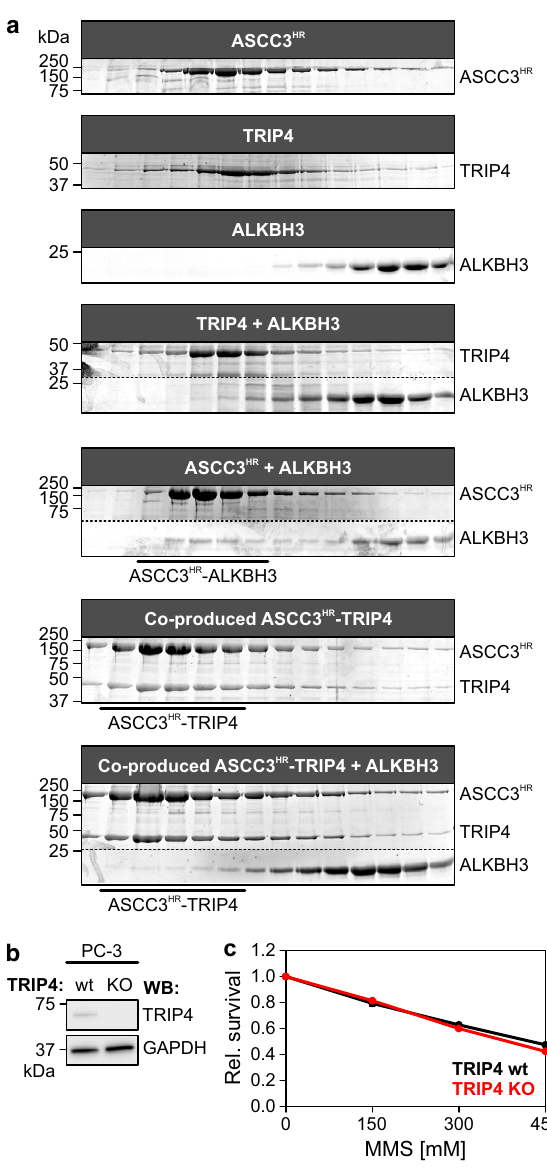
Fig. 5 | TRIP4 and ALKBH3 may conscribe ASCC core subunits for distinct Table 1 | DNA – protein cross-links identi fi ed by MS cellular functions. a SDS-PAGE analyses of analytical SEC elution fractions monitoring the competitive binding of TRIP4 and AlkBH3 to ASCC3 HR . Cross-linked pepide a Cross-linked Trial Domain Motif b Throughout all panels, equivalent elution fractions are vertically aligned. Input residue or region samples are identi fi ed on top of each run. Molecular mass markers in kDa are shown on the left; protein bands are identi fi ed on the right. Stable complexes elutingfromsomeanalyticalSECrunsareidenti fi edbelowtherespectivegels.For some analytical SEC runs, separate regions of the same gel were spliced together for display purposes (see Source Data fi le for uncropped gels). Dashed lines, splice lines. TRIP4 and AlkBH3 do not stably interact (run 4). AlkBH3 and TRIP4 form stable binary complexes with ASCC3 HR (runs 5 and 6). AlkBH3 is excluded from a pre-formed ASCC3 HR -TRIP4 complex (run 7). Experiments were repeated independently at least three times with similar results. b Western blots doc- umenting CRISPR/Cas9-mediated KO of TRIP4. GAPDH was used as a loading control. c Assay comparing the relative degree of viability of TRIP4 wt and KO PC-3 cells in the presence of increasing concentrations of MMS. TRIP4 wt cells, black;TRIP4KOcells,red.Valuesrepresentmeans±SD; n =5technicalreplicates. Error bars are hidden by data points. Source data are provided as a Source Data fi